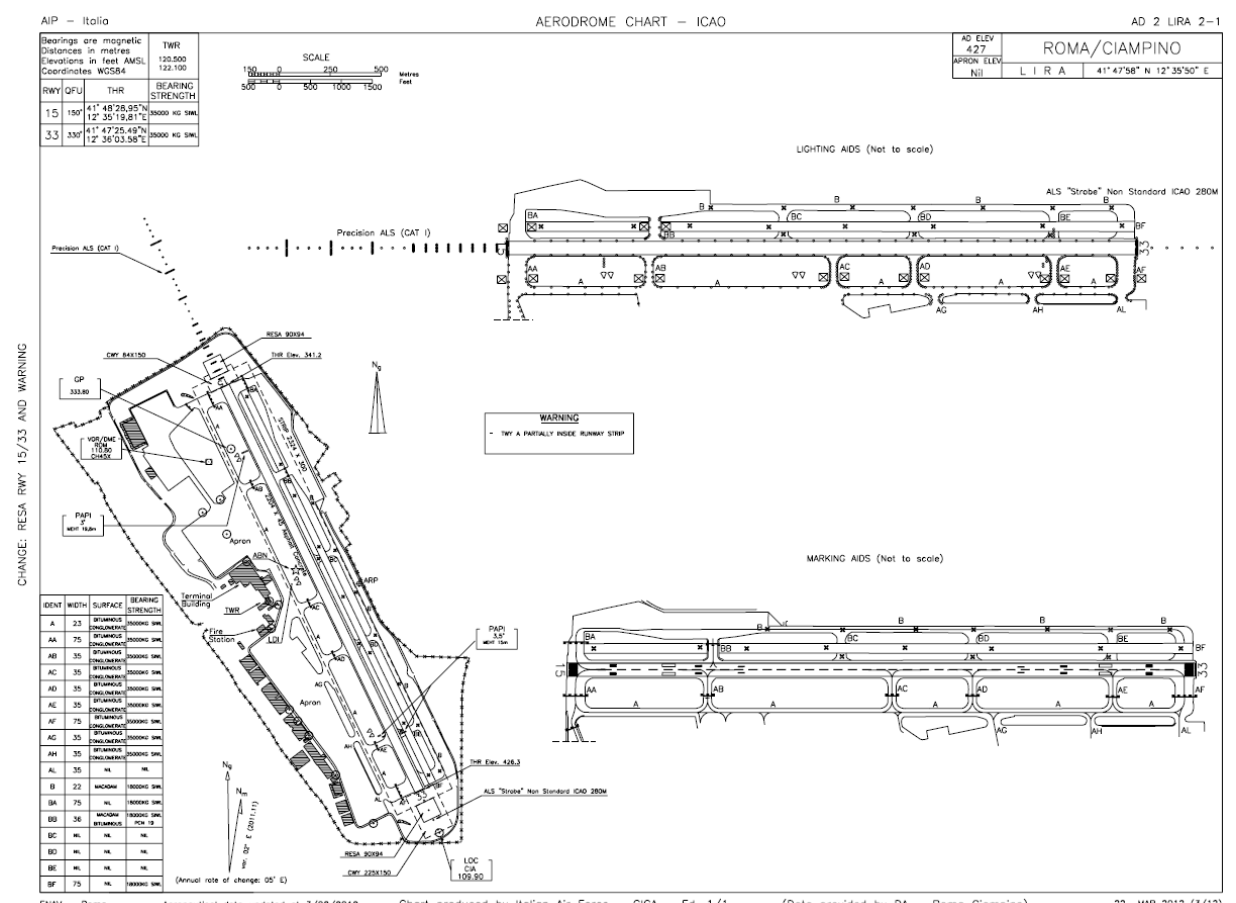
Figure 6. LIRA aerodrome chart (taken from